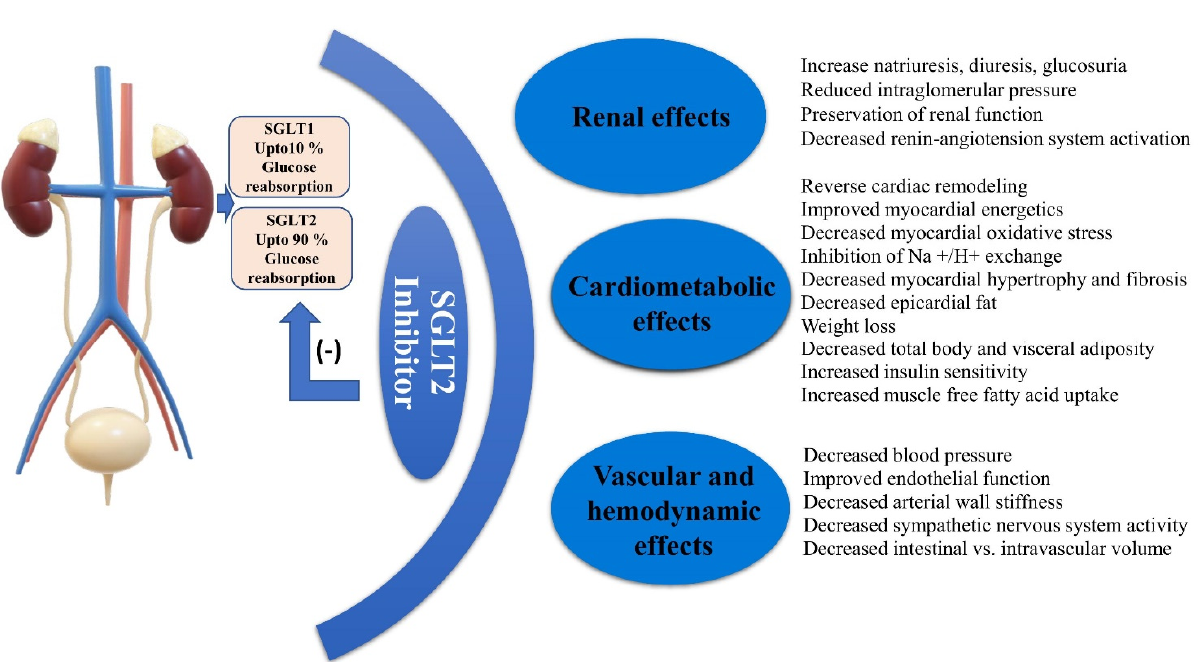
Figure 2. The proposed cardiovascular axis of SGLT2 inhibitor via several pleiotropic mechanisms.